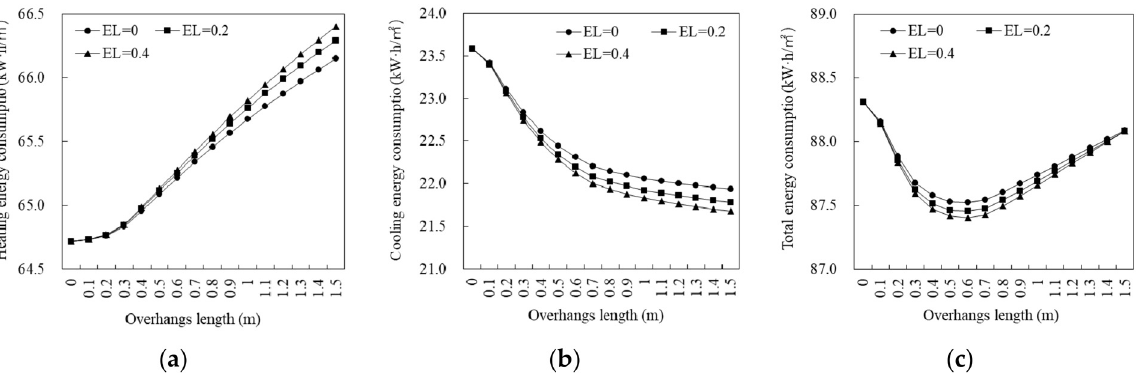
Figure 13. Relationships between overhang length and energy consumption: ( a ) heating; ( b ) cooling; ( c )